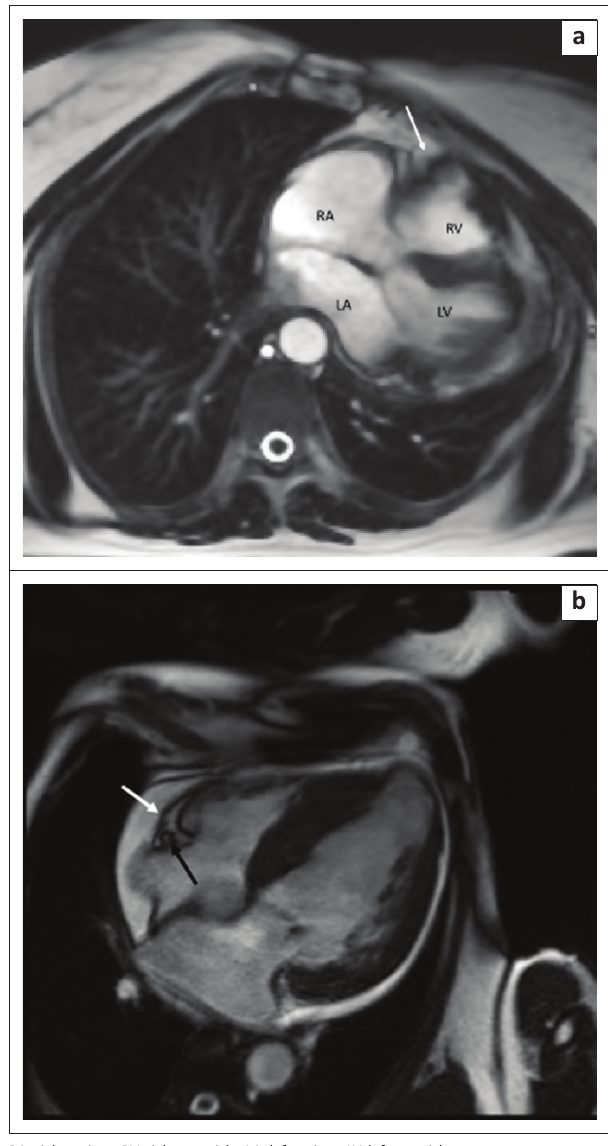
FIGURE 1: A 19-year-old man with absent pericardium. The axial SSFP image (a) demonstrates left lung ( * ) herniating into the space between the aorta (Ao) and main pulmonary artery (PA). Normally (b) the pericardium is seen as a thin grey line (white arrow) bridging the space between the aorta (Ao) and pulmonary artery (PA).